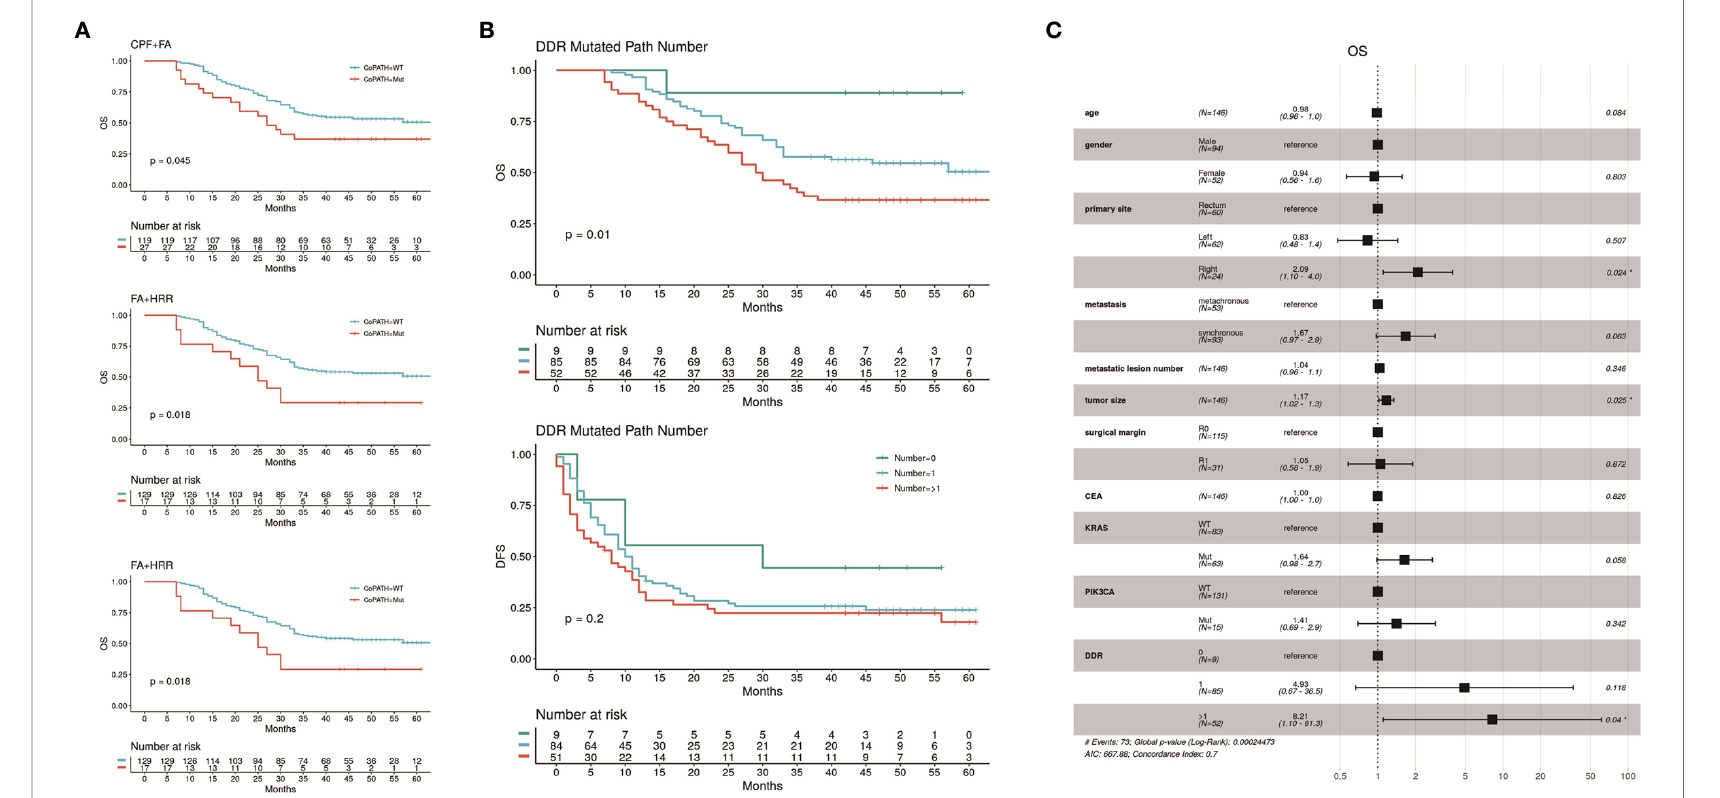
FIGURE 4 | (A) Kaplan-Meier curves of OS and DFS showing differences between subgroups with and without speci fi c co-mutations of two DDR pathways. The subgroups carrying co-mutations in CPF + FA or FA + HRR pathways had signi fi cantly worse OS, and the FA + HRR subgroup also had signi fi cantly worse DFS. The results with insigni fi cant correlations were shown in Supplementary Table 3 . (B) the patients carrying mutations in more than one DDR pathway had the worst OS comparing with those with 1 or 0 mutated DDR pathway mutations. The DFS of these three subgroups were also distinguishable, but with less signi fi cance. (C) Result of multivariable Cox proportional hazards regression analysis of OS, including the number of mutated DDR pathways, as well as clinical factors previously reported independently associated with CRC prognosis. Carrying more than one mutated DDR pathways maintained signi fi cant negative correlation with OS (HR = 9.14, 95% CI: 1.21 – 68.9). The analysis of DFS showed no signi fi cance, and result was attached in Supplementary Figure 4